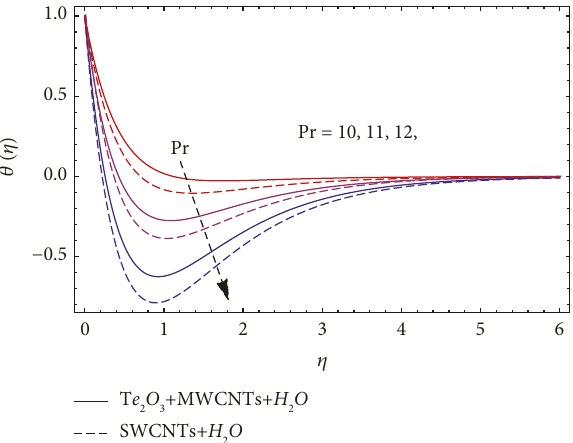
Figure 13: Influence of prenatal number on temperature